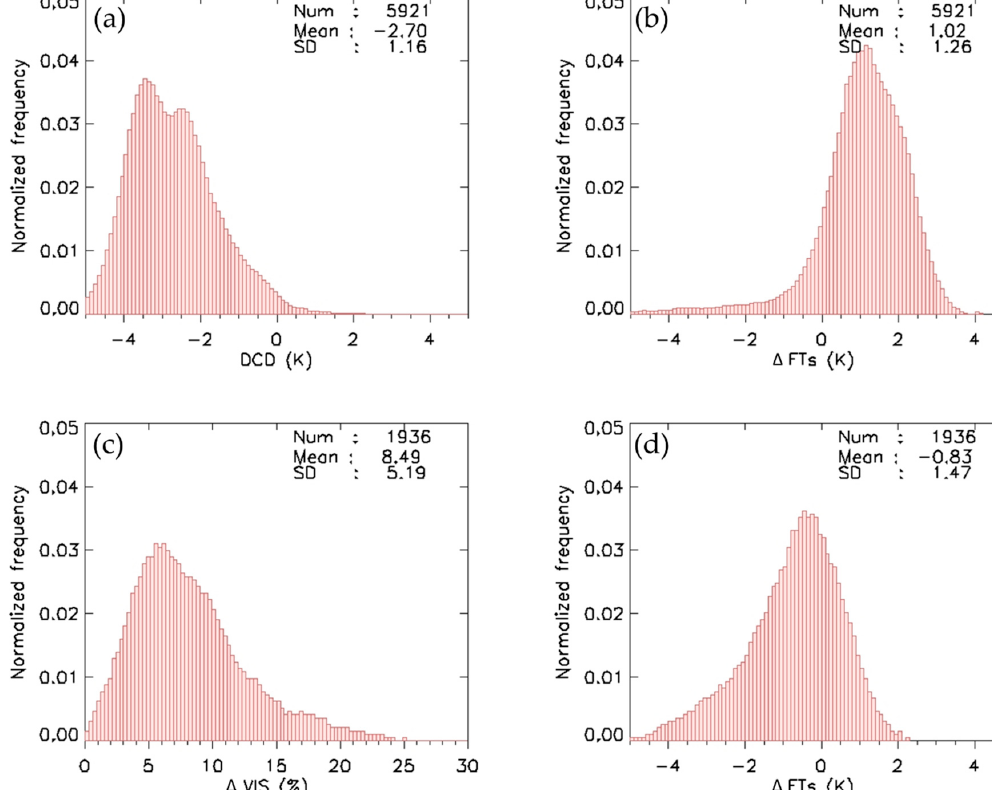
Figure 5. Frequency distribution of the optical / textural properties of fog pixels in the training cases at nighttime ( a , b ) and daytime ( c , d ). ( a ) Dual Channel Difference (DCD), ( b , d ) Difference between the BT of the fog top and surface temperature ( Δ FTs), and ( c ) Difference between the reflectance of 0.64 μ m (VIS0.6) and Vis_Comp ( Δ VIS).